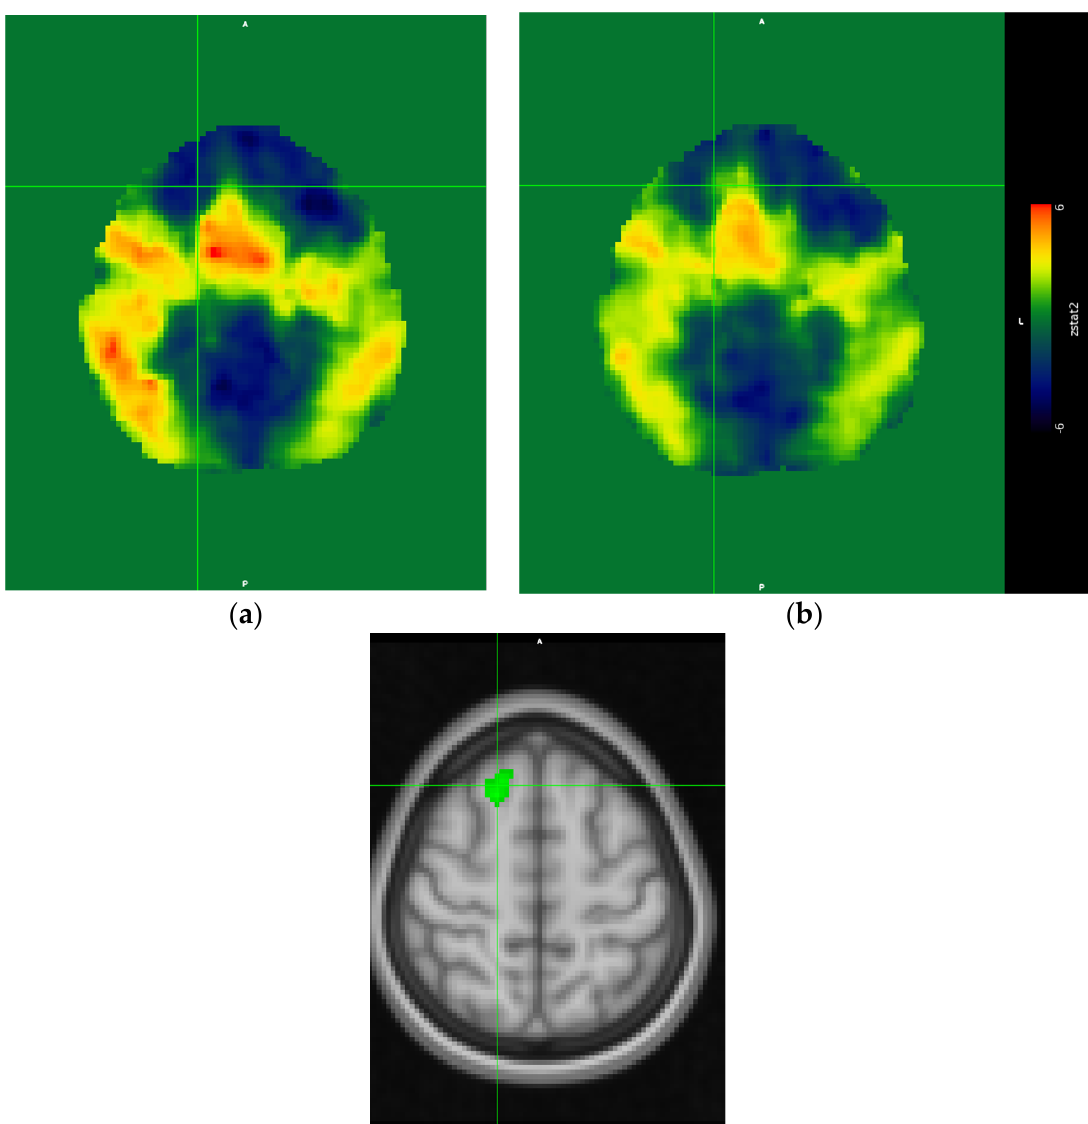
Figure 4. Unthresholded Z-statistics image of rested condition results ( a ), unthresholded Z-statistics image of the fatigued condition results ( b ). Note the larger extension of activations in the rested condition ( a ) as compared to the fatigued condition ( b ). The region of statistically significant differences; i.e., the contrast fatigued > rested conditions thresholded at Z > 3.1 ( c ). The crosshairs indicate the same voxel at the center of the suprathreshold cluster in the right superior frontal gyrus (MNI coordinates: x = 18, y = 26, y = 56, cluster volume = 136, Z-score (maximum—4.53)).